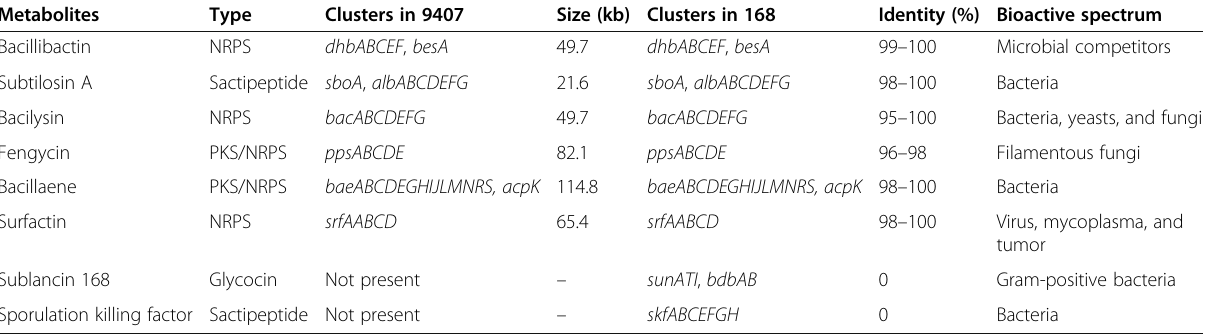
Table 2 Comparison of predicted BGCs between genomes of the B. subtilis strains 9407 and 168